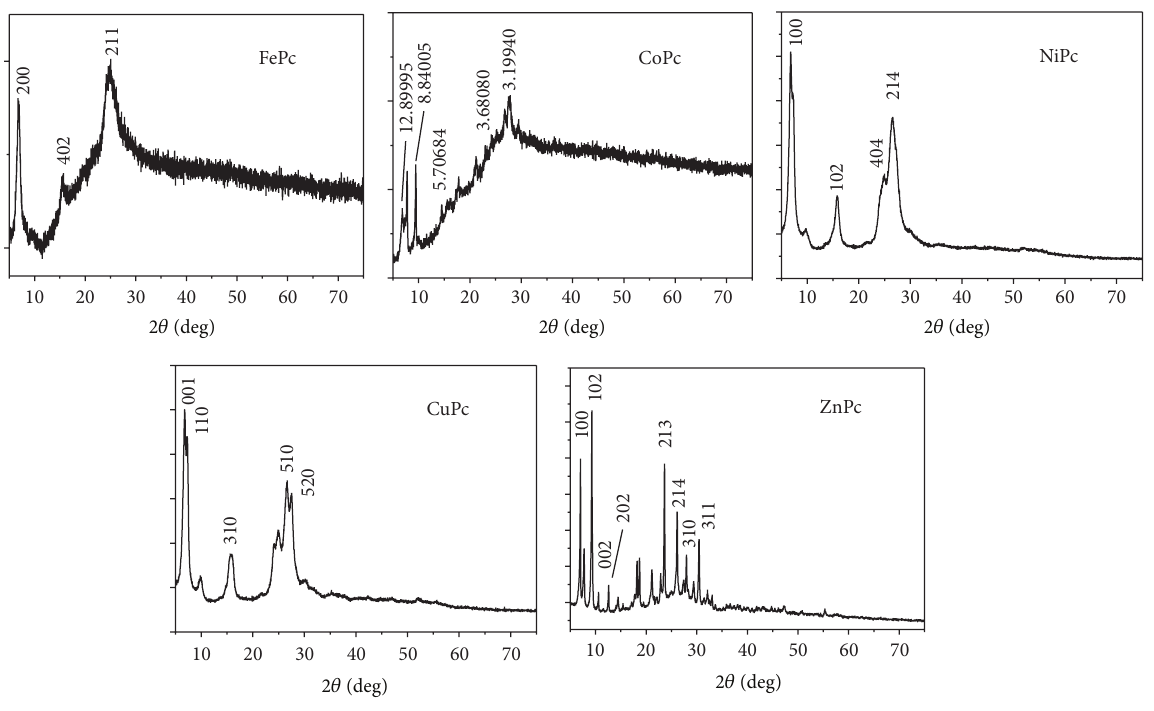
Figure 2: XRD patterns of the MPcs.